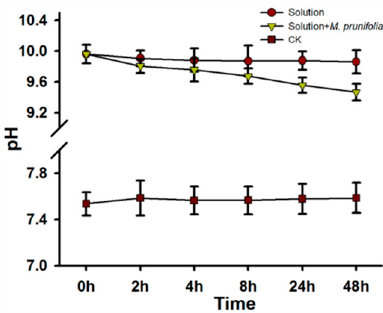
Figure 7. The time course of in hydroponics solution pH under alkaline stress for 48h. The points, triangles, and squares represent mean value ± SD of three biological repeats. CK: the hydroponics solution with the apple rootstock without alkaline stress.